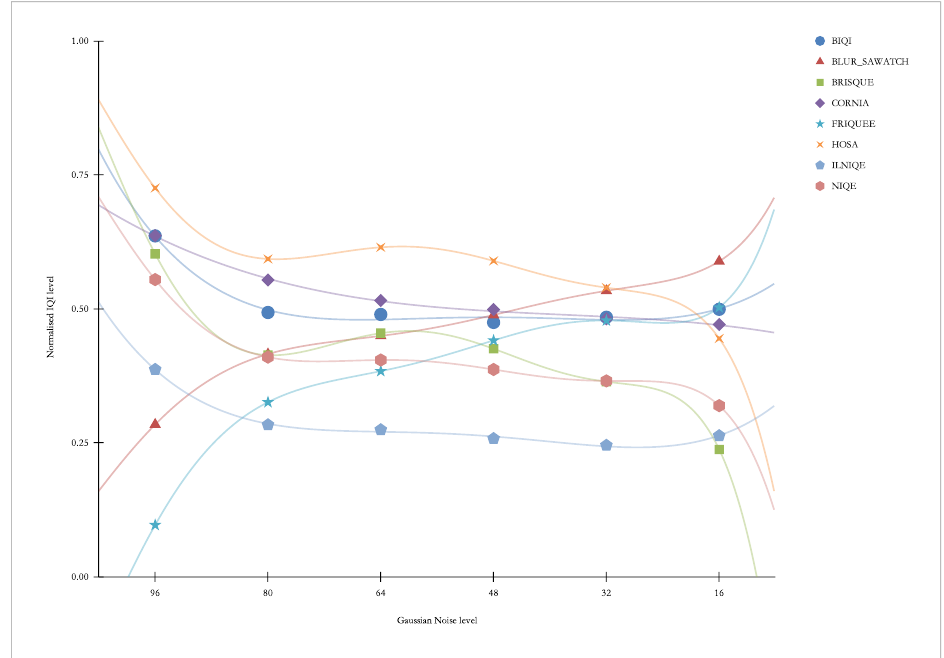
Figure 18. “Other” indicators vs. Gaussian Noise [ σ